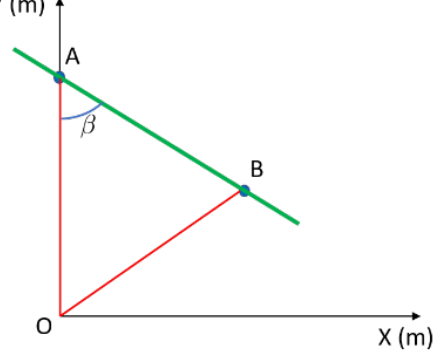
Figure 5. Arbitrary Points A and B with respect to the Sensor at O.